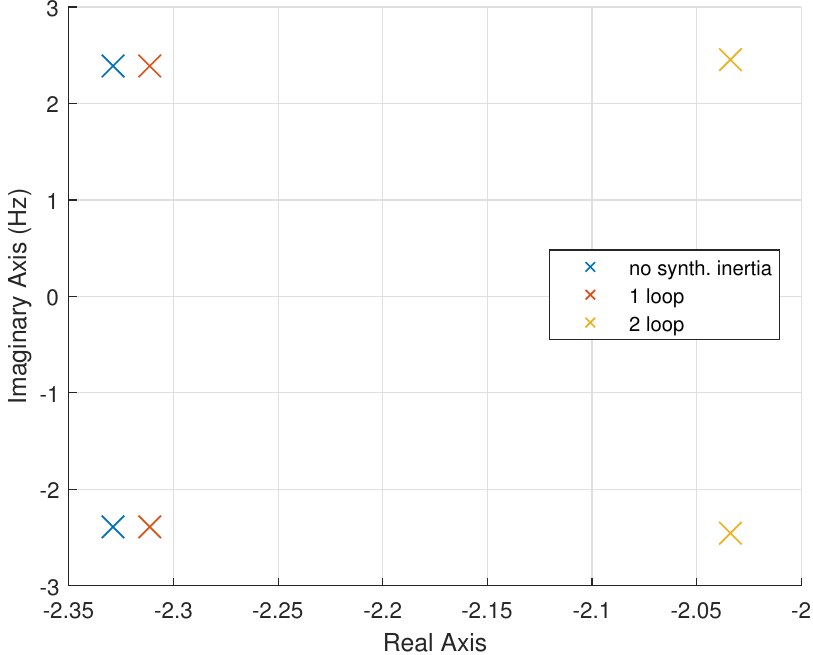
Figure 6. Pole-plot of dominant eigenvalues for ∆ ω modes—scenario 2.